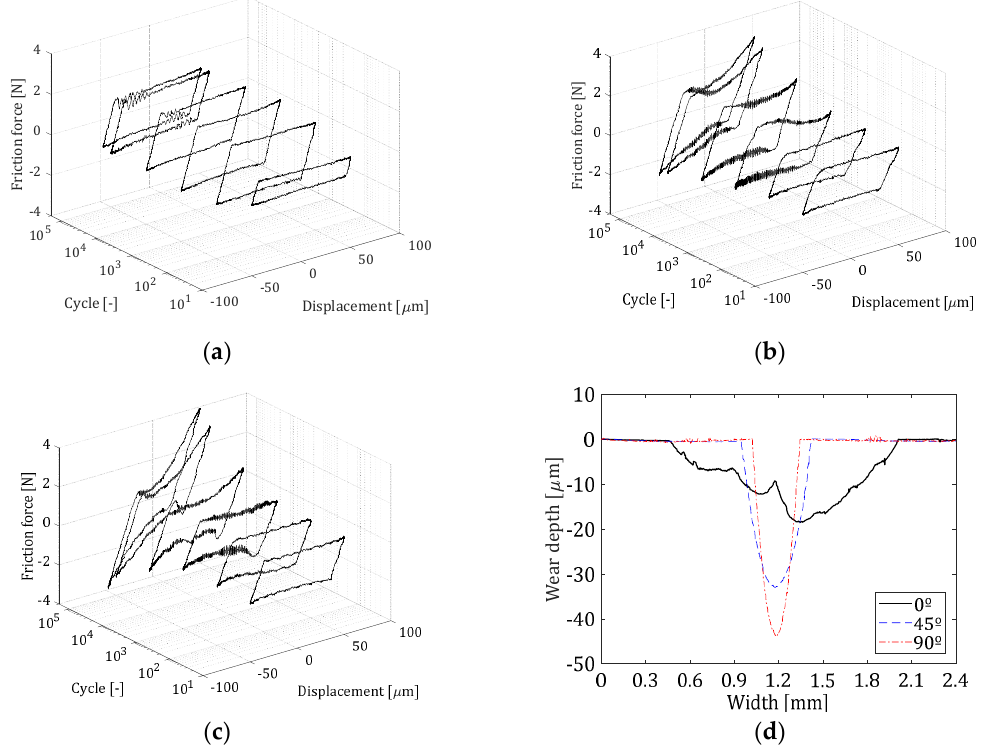
Figure 10. Evolution of the tangential force during tests and wear scar results: ( a ) 0 ◦ crossing angle; ( b ) 45 ◦ crossing angle; ( c ) 90 ◦ crossing angle; ( d ) comparison of the wear profile of each crossing angle test at 150 × 10 3